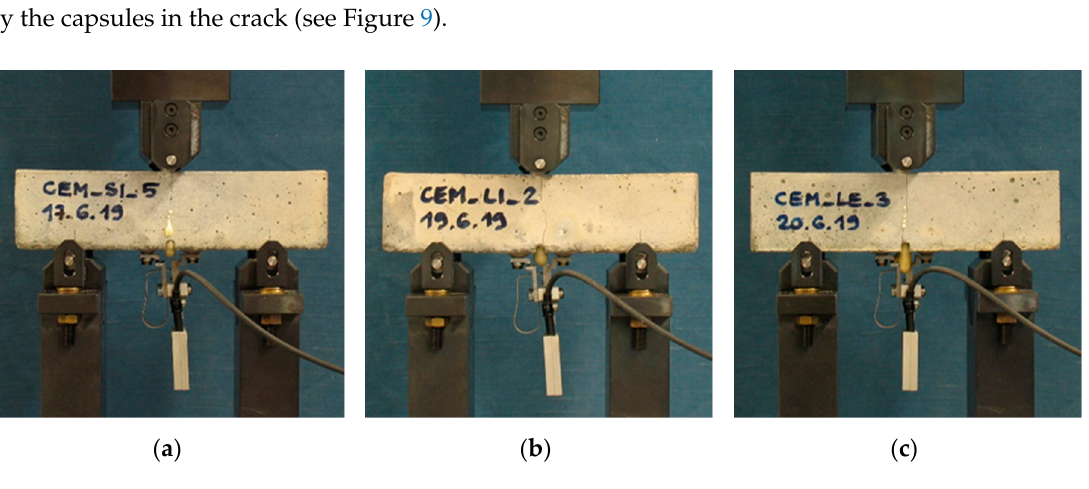
Figure 9. Leakage of polyurethane upon capsule breakage during pre-cracking: ( a ) Polyurethane (PU) visible both at the crack mouth inside the notch and on the lateral faces for a CEM_SI specimen; ( b ) PU visible at the crack mouth inside the notch for a CEM_LI specimen; ( c ) PU visible both at the crack mouth inside the notch and to a lesser extent on the lateral faces for a CEM_LE specimen.